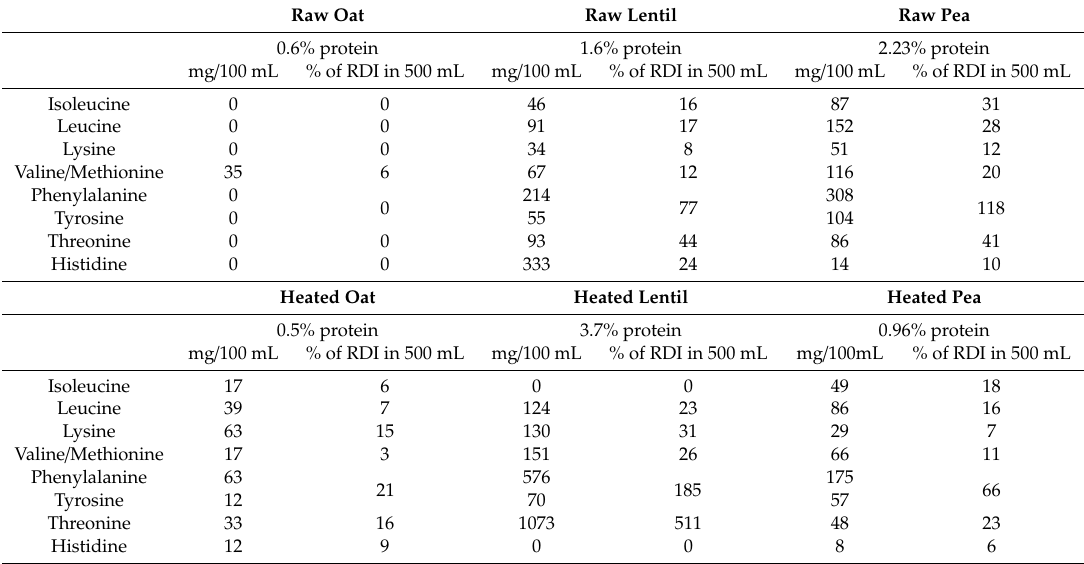
Table 3. The essential amino acids measured in the supernatant of the single ingredient PBDs. Raw